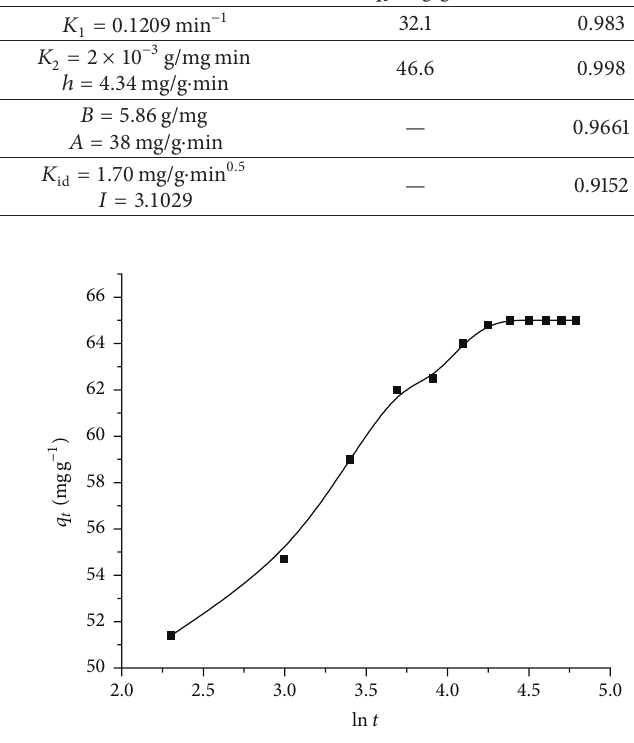
Figure 12: Elovich kinetic model for the adsorption of Hg(II) onto ALP biomass.